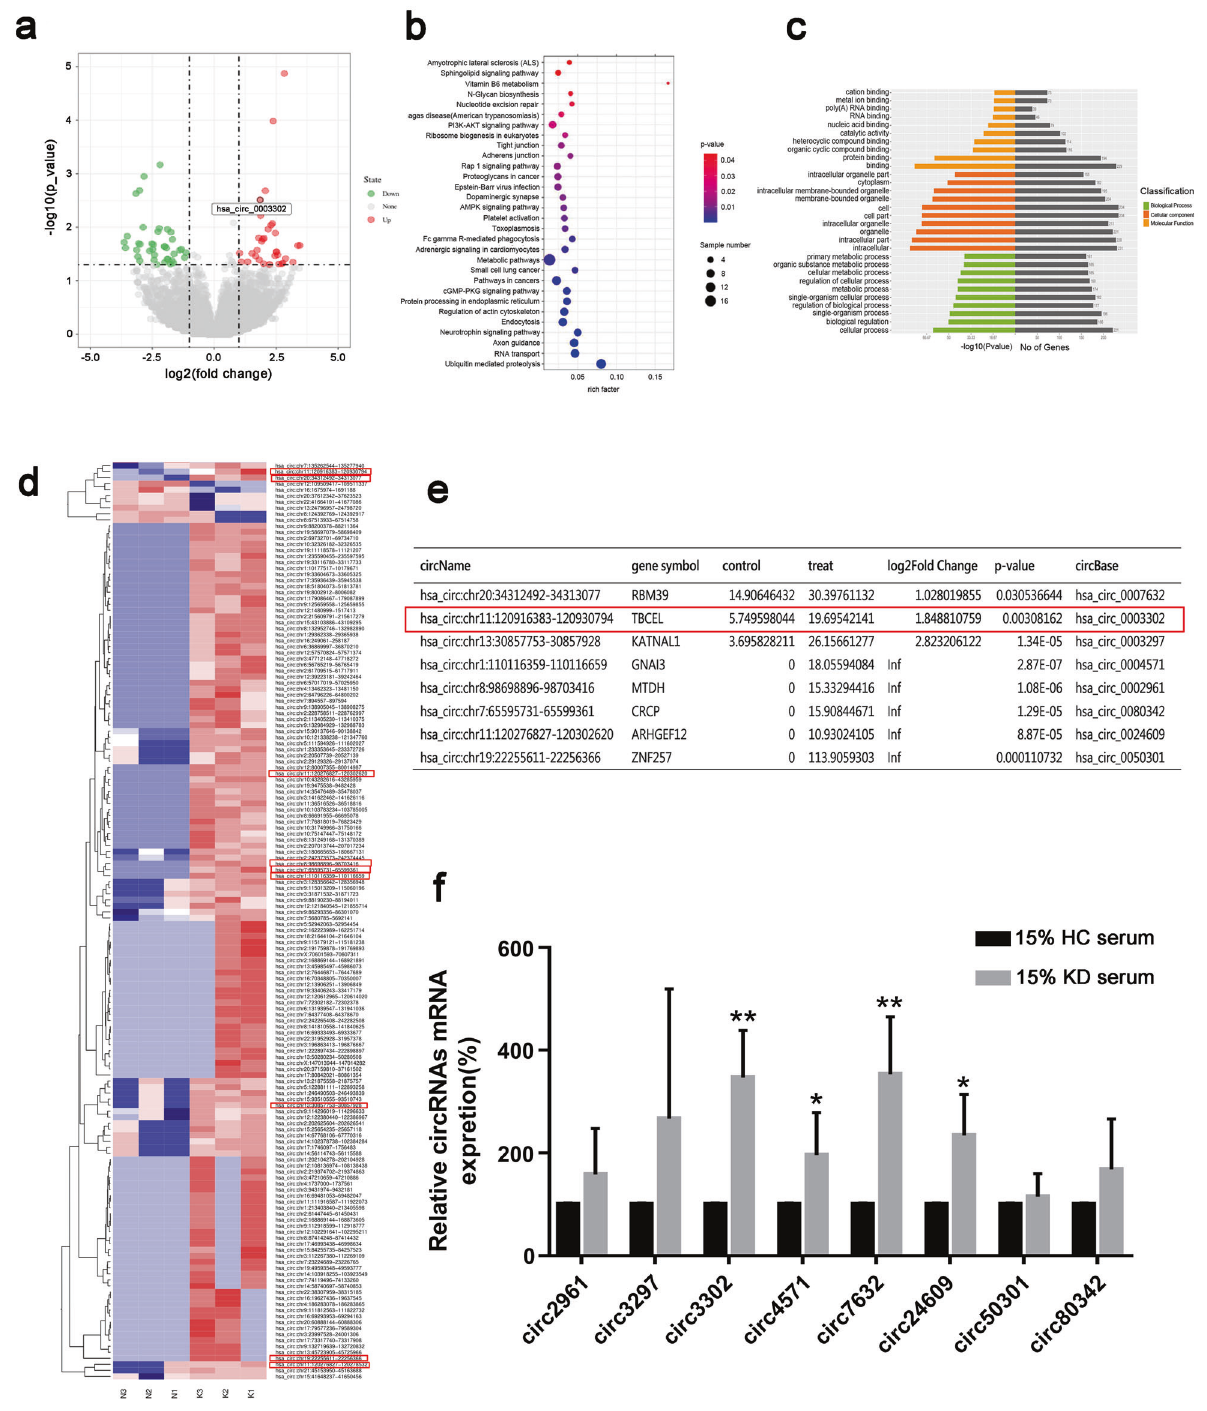
Fig. 2 Sequencing results of circRNAs in KD-related EndoMT in vitro model and screening of candidate genes. a CircRNA expression pro fi ling (Volcano plot) of HUVECs treated with 15% KD serum versus 15% HC serum (green represented the downregulated circRNAs and red represented the upregulated circRNAs). b KEGG pathway analysis of upregulated circRNAs in HUVECs treated with 15% KD serum when compared with 15% HC serum. The size of the dot represented the gene number included in the biological pathway, and the color represented P value. c Gene Ontology (GO) analysis of upregulated circRNAs in HUVECs treated with 15% KD serum when compared with 15% HC serum. d Heatmaps illustrated the expression of upregulated circRNAs. e Table of candidate signi fi cantly differential genes. f The expression of eight candidate circRNAs was con fi rmed by RT-qPCR analysis. Data were shown as mean ± SD ( n = 3). * P < 0.05, and ** P < 0.01 vs. the HC group.